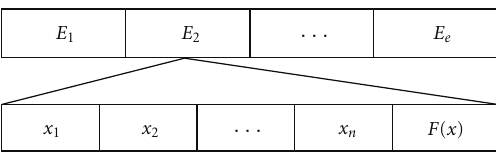
Figure 3: Data structure of situational